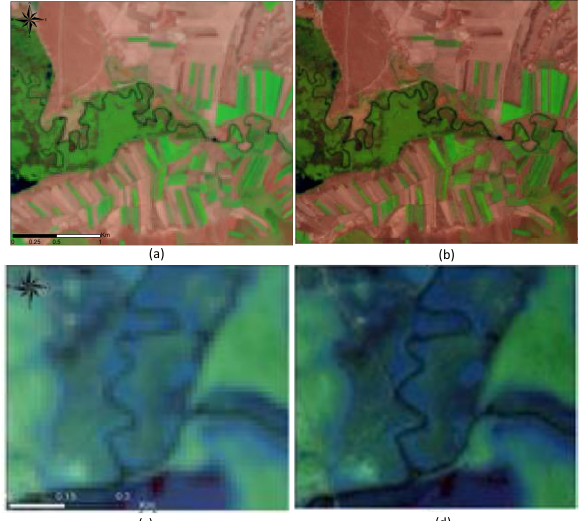
Figure 2. Sentinel-2 Pan Sharpening results: a) 20 m (RGB –